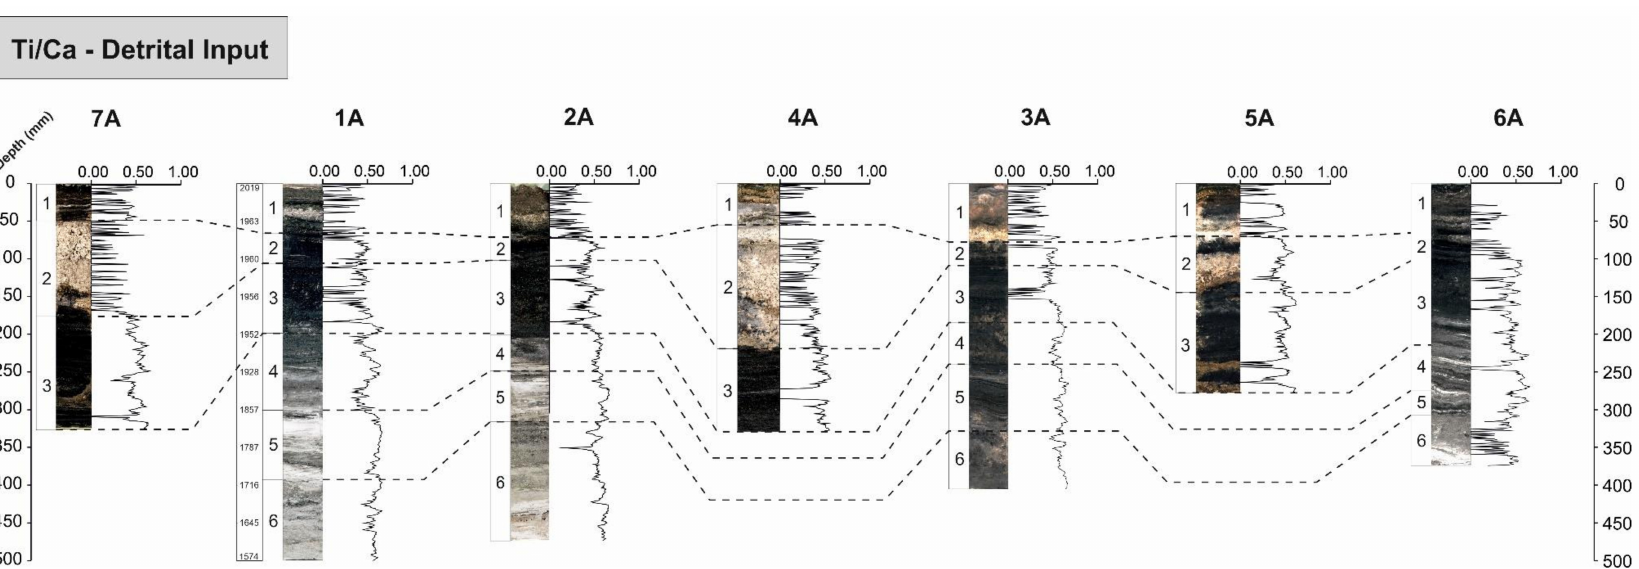
Figure 10. Figure illustrating spatio-temporal variations in geochemical proxies typically used for determination the degree of detrital input [61]. Increasing values indicate increasing detrital